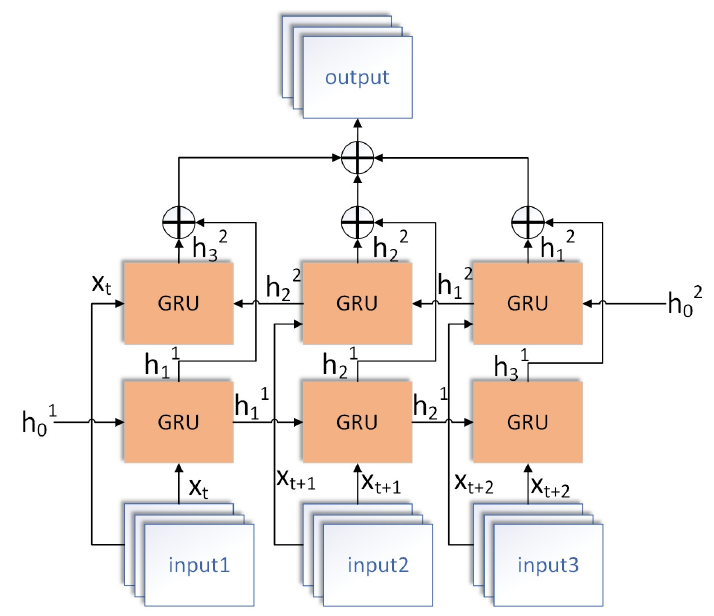
Figure 6. Network structure of